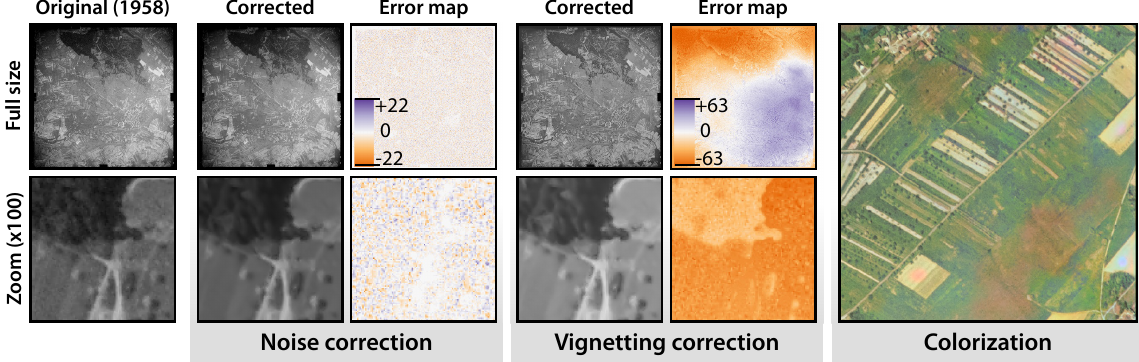
Figure 3. Step-by-step results for the proposed correction and harmonization pipeline. Results are given for the 1958 photograph, as it was the most deteriorated. The original photograph and correction results are presented so as to show the contribution of each step. Error map are also provided, and correspond to the difference between the original and the corrected picture. Finally the colorization result is presented for the studied area.